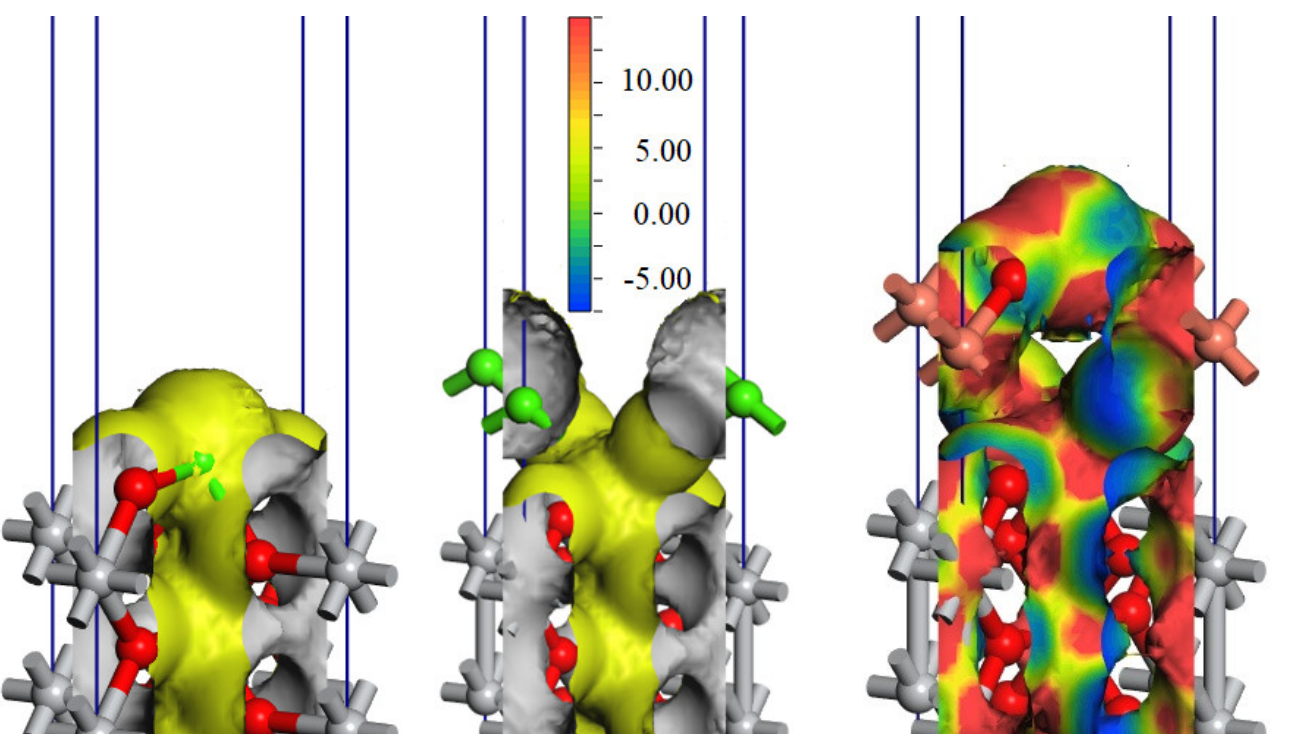
Figure 6. The isosurfaces of the electrostatic potential for pristine TiO 2 (001) ( left ), Ca-deposited TiO 2 (001) surfaces ( center ), and the thin film of Cu 2 O(001) formed on Ca-TiO 2 (001) ( right ), where TiO 2 is considered with the structure of rutile polymorph. The color map is given for values between −7.5 (blue) and 15 eV (red), with the yellow color corresponding to 5 eV. It can be seen that the addition of the Ca on the TiO 2 (001) surface, where Ca atoms form strong bonds with the dangling free oxygen atoms from the top of the TiO 2 (001) surface, determines a perturbation in the averaged electrostatic potential on the surface plane, with about −12.2 eV at the position of the calcium atom compared with about −22.4 eV at the position of the titanium located below the calcium atom. Thus, an external potential perpendicular to the TiO 2 (001) surface is